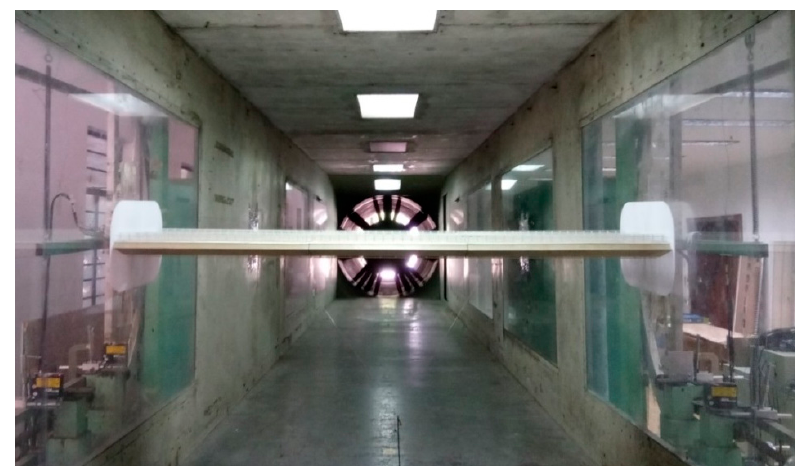
Figure 1. View of the spring-suspended sectional model in TJ-1 wind tunnel.